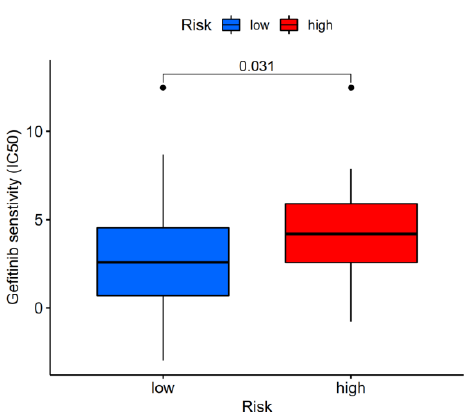
Figure 8. Sensitivity analysis of the Gefitinib drug in high- and low-risk patients, the drug was sensitive to the low-risk group of AD and p < 0.05.